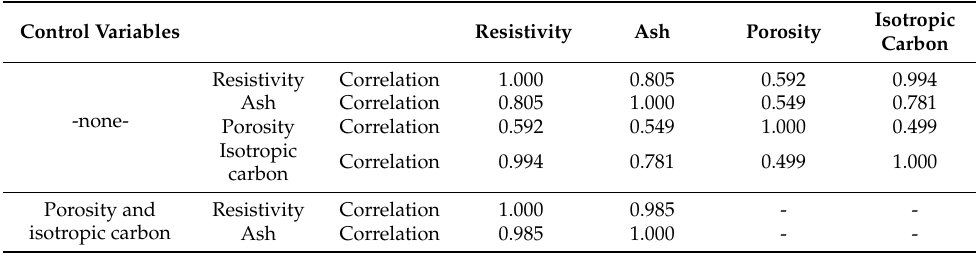
Table 7. Correlation matrix of coke resistivity and coke ash content while controlling for both precent Isotropic carbon content and porosity.